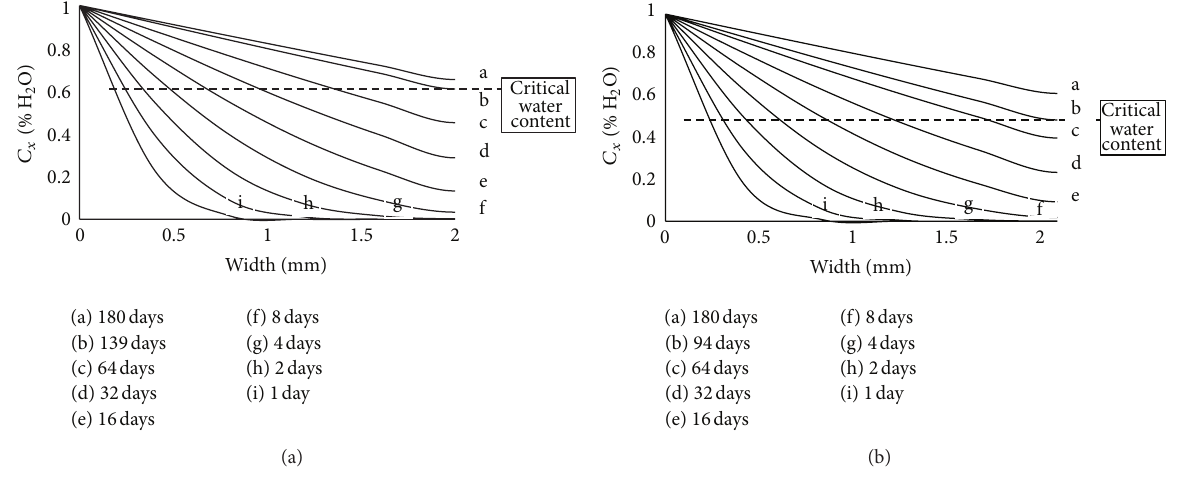
Figure 3: Concentration profiles of seawater in MCB test specimens as a function of immersion time: (a) polyurethane and (b) vinylester.